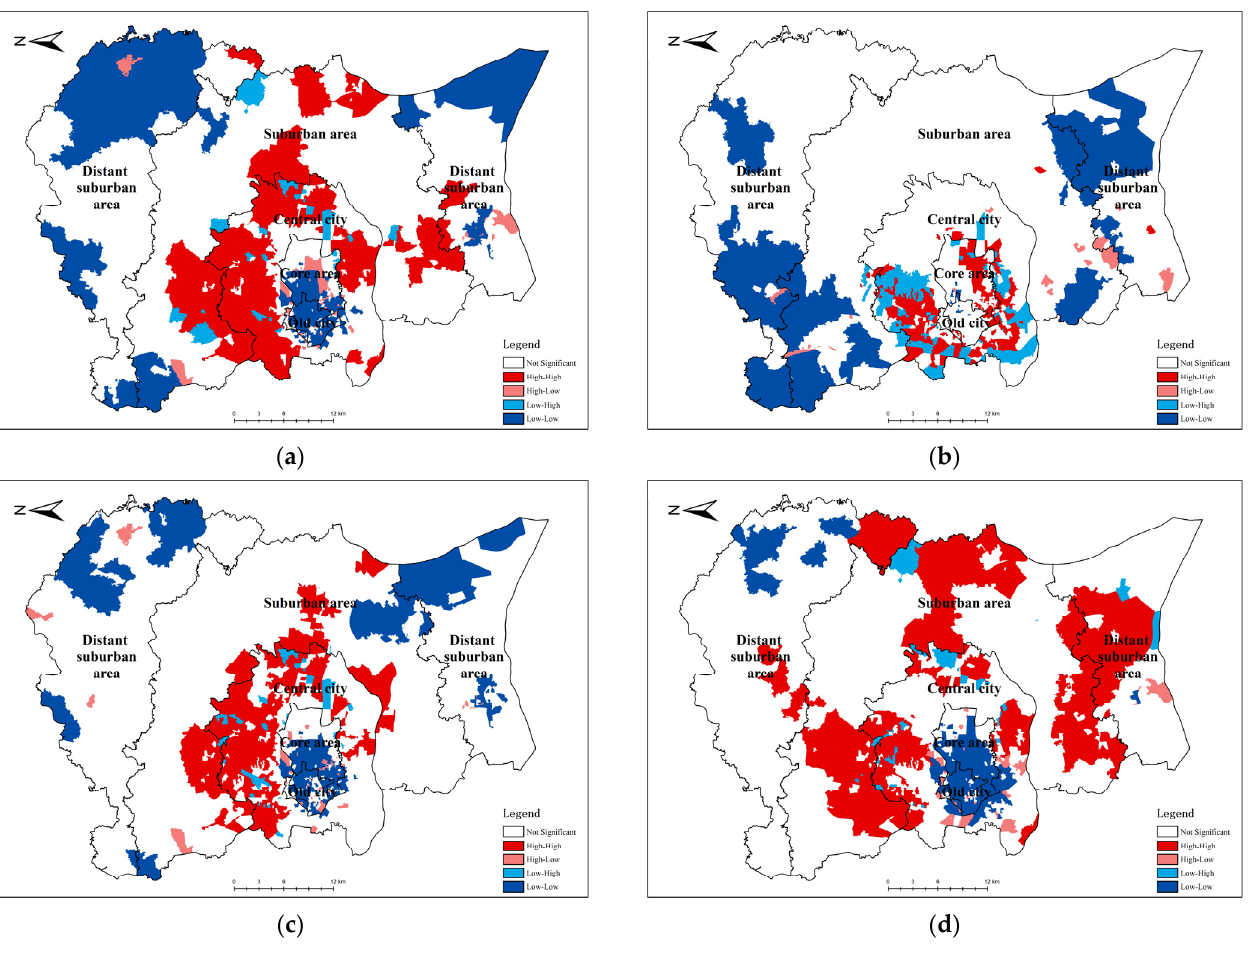
Figure 4. Moran’s I index distribution diagram of the floating population with different household registration. ( a ) The entire floating population; ( b ) the FPFOD; ( c ) the FPFOC; ( d ) the FPFOP.